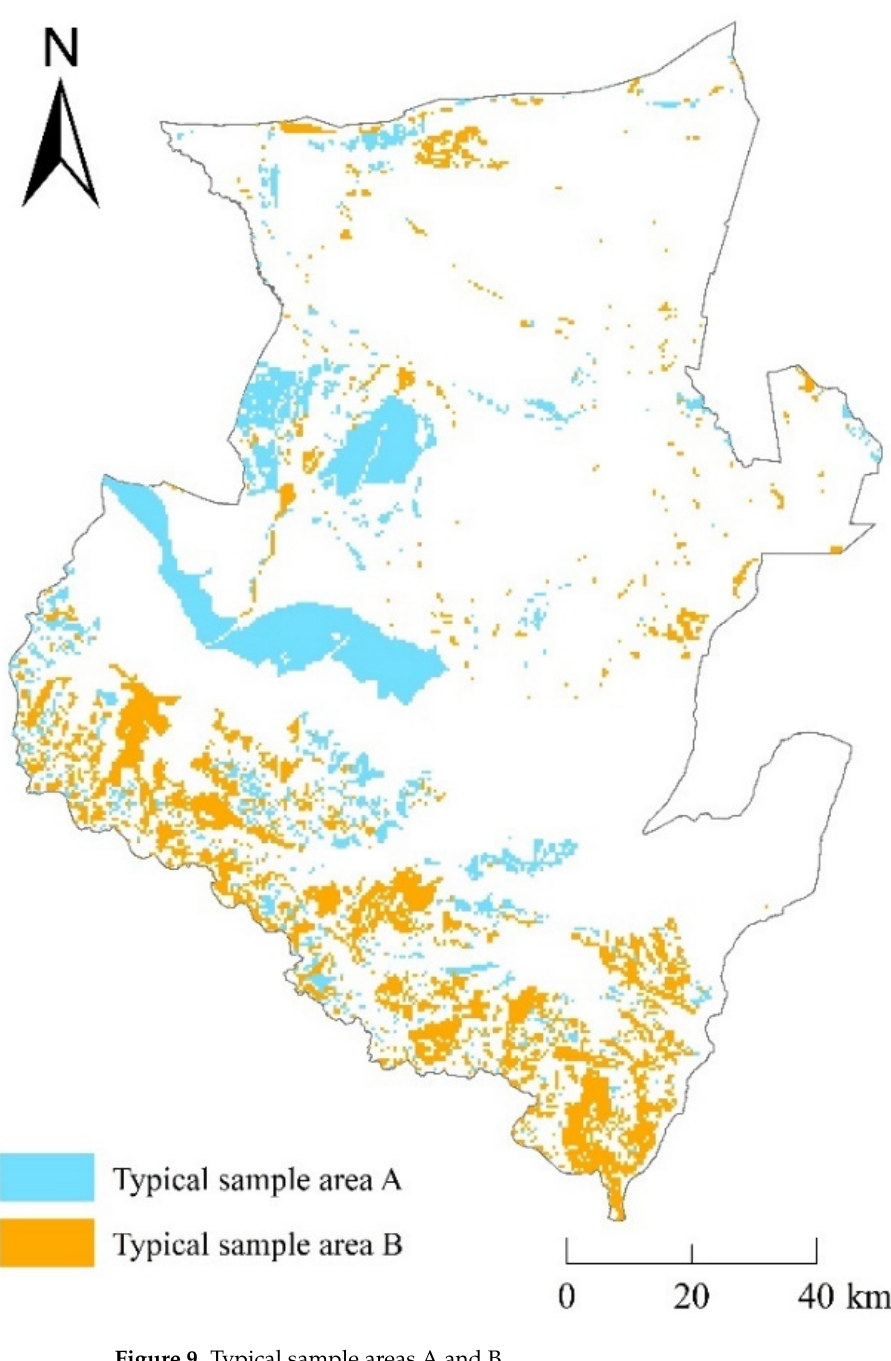
Figure 9. Typical sample areas A and B.